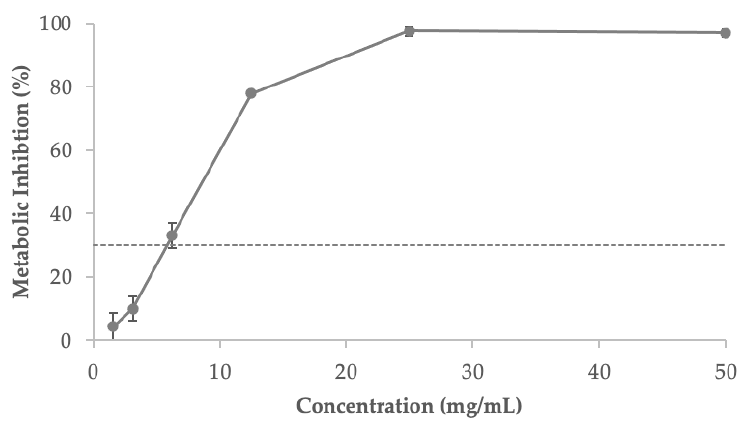
Figure 6. The metabolic inhibitory action of the fermented sugarcane straw extract on the intestinal Caco-2 cell line, as a base for estimating its cytotoxicity profile. The dotted line shows the 30% cytotoxicity threshold. Values expressed are the mean ± standard deviation.